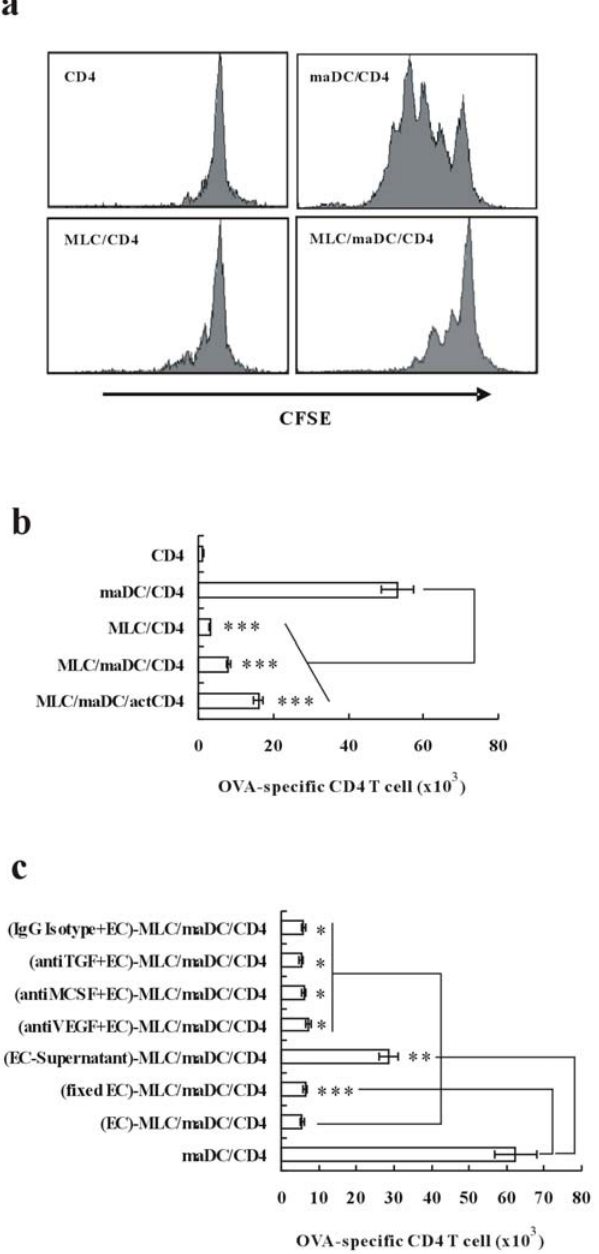
Figure 4. MLCs inhibit maDC-induced proliferation of CD4 T cells. CD4 T cells from DO11.10 6 C57BL/6 F1 hybrid mice were cocultured with maDCs and/or MLCs for 5 days. (a) Proliferation of CD4 T cells in the coculture system were demonstrated by CFSE dilution. (b) MLCs were added into the maDC/CD4 T coculture system simultaneously or 24 h after maDC coculture with CD4 T cells. Live CD4 T cells in the coculture system were counted by a flow cytometer. Data are presented as mean 6 s.d. of triplicate wells and representative of three independent experiments. (c) Fixed endothelial cells (EC) or endothelial supernatant were used to culture DC or neutralizing antibodies against TGF- b , M-CSF or VEGF were added into the endothelial-DC coculture system(5 ug/ml, each antibody), then the differentiated MLC were added into the maDC/T cell coculture system. 3 days later, the alive T cells were counted by FACS. ** , P , 0.05. *** , P , 0.01.